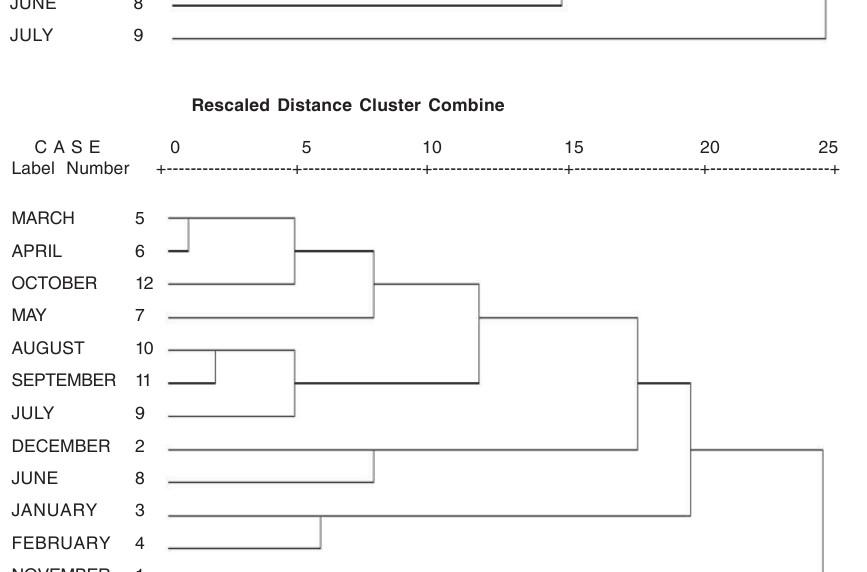
Figure 2. Hierarchical cluster analysis of microcrustacea (2002-03)